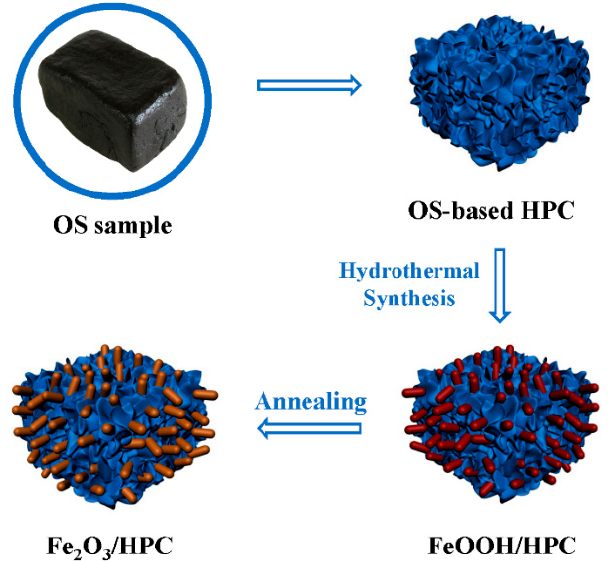
Figure 1. Schematic procedure for the fabrication of FPC electrode materials.